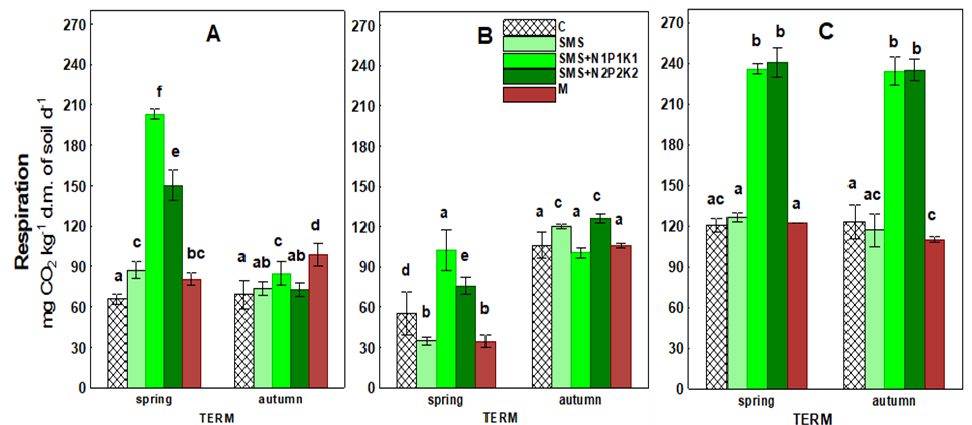
Figure 3. Respiratory activity in control soil and soil under different treatment strategies. ( A ) 1st year; ( B ) 2nd year; and ( C ) 3rd year. C — control soil; SMS — soil + spent mushroom substrate; SMS + N1P1K1 — soil + spent mushroom substrate + mineral fertilization N1P1K1; SMS + N2P2K2 — soil + spent mushroom substrate + mineral fertilization N2P2K2; and M — soil + manure. The vertical lines indicate the standard deviation. Different letters above the columns indicate significant differences at p < 0.05, and each year was analyzed independent of each other. Table 3. Biochemical, enzymatic activity and soil phytotoxicity parameters (annual spent mushroom substrate. Stimulation of this process was recorded in the manure sites